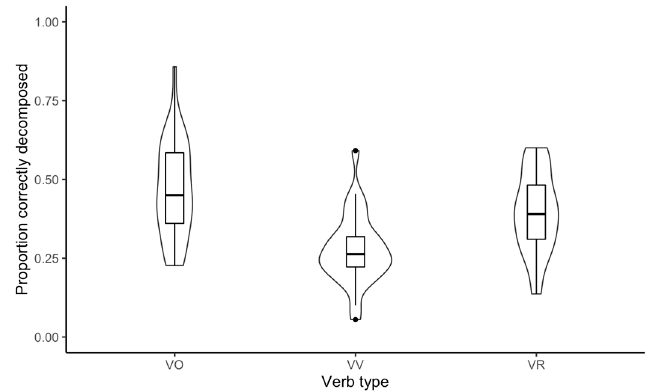
Figure 1. The mean accuracies of decomposing verbs across three verb types.